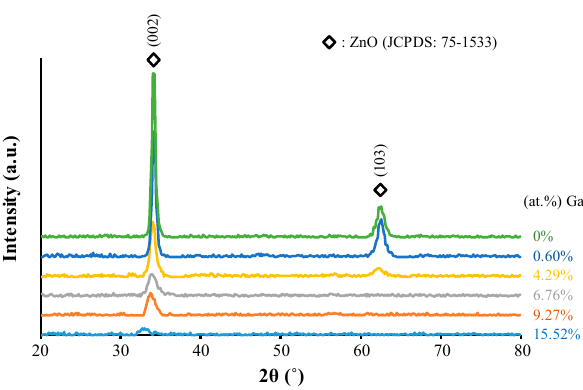
Figure 2. X-ray diffraction (XRD) patterns of ZnO thin films with varying amounts of Ga.